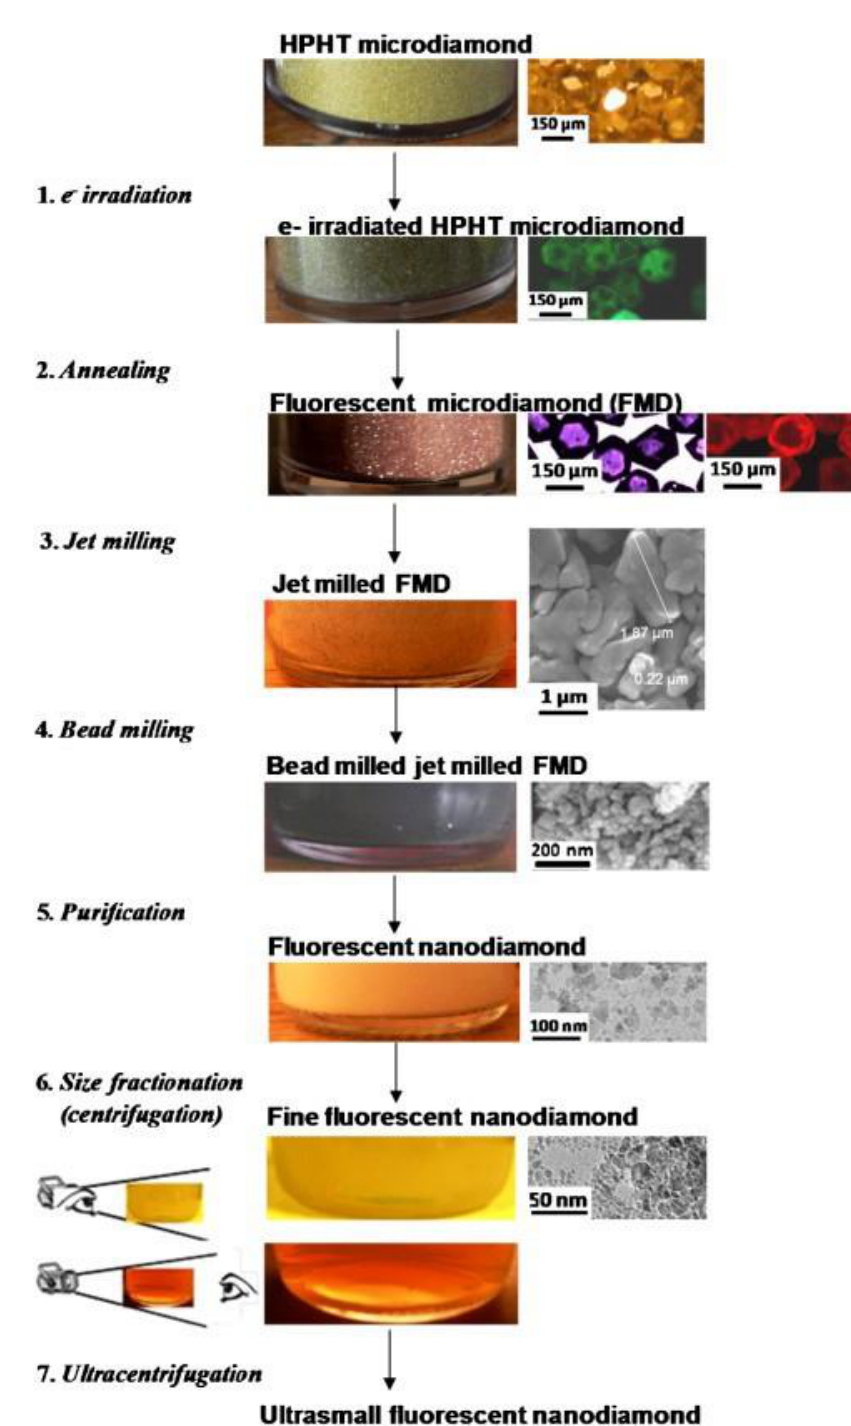
Figure 6. Nitrogen-vacancy ( NV)-enriched NDs preparation. Reproduced with permission from [23], Elsevier, 2013.